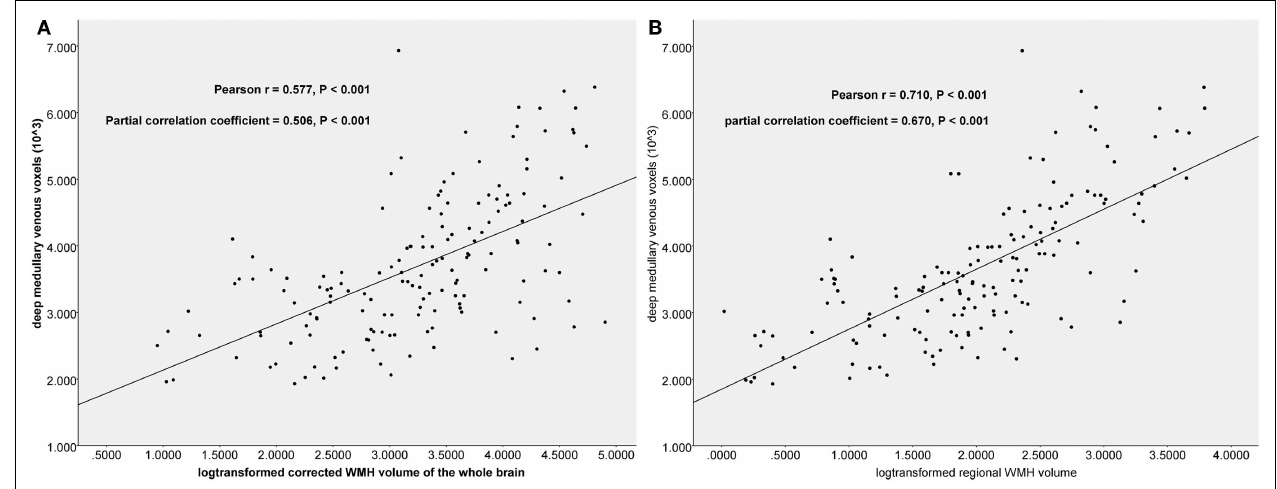
for age, sex, years of education, and number of microbleeds and lacunes. (A) The correlation between voxel count andWMH volume of the whole brain. (B) The correlation between voxel count and the regionalWMH